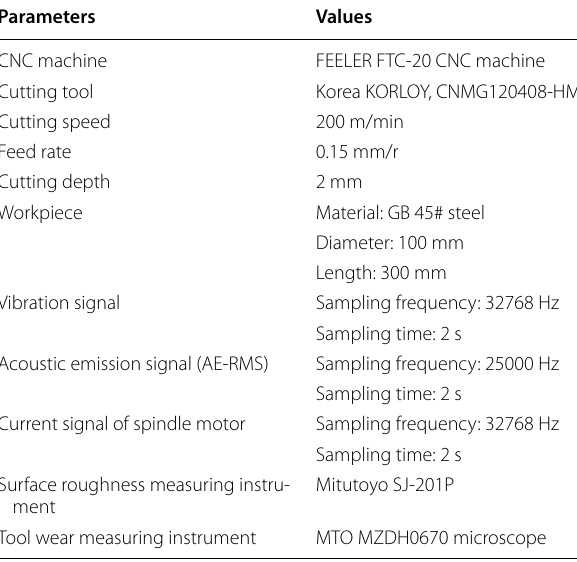
Table 4 Details of the second experimental case